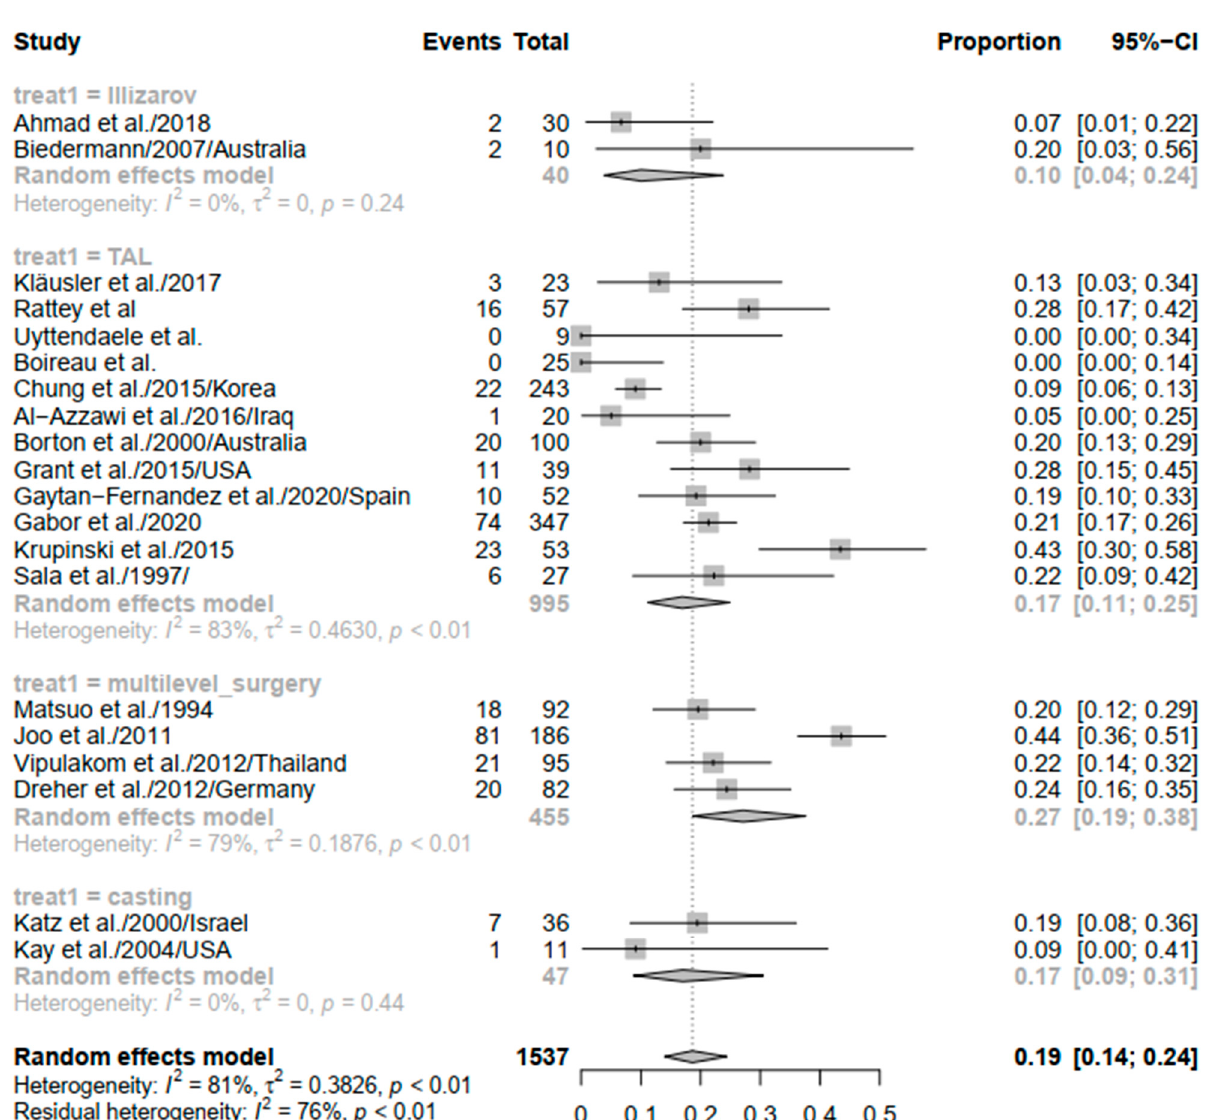
Figure 6. Forest plot of the subgroup analysis of equinus recurrence based on intervention type.